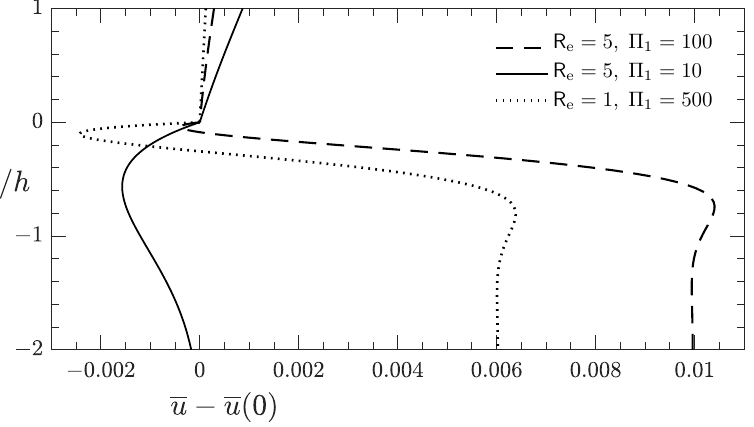
Figure 10. Steady streaming velocity relative to ¯ u ( z = 0 ) for ˜ ω = 0.08. See text for